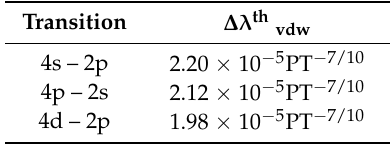
Table 1. van der Waals width formulas for the three radiative transitions of the H- β line in helium plasma.